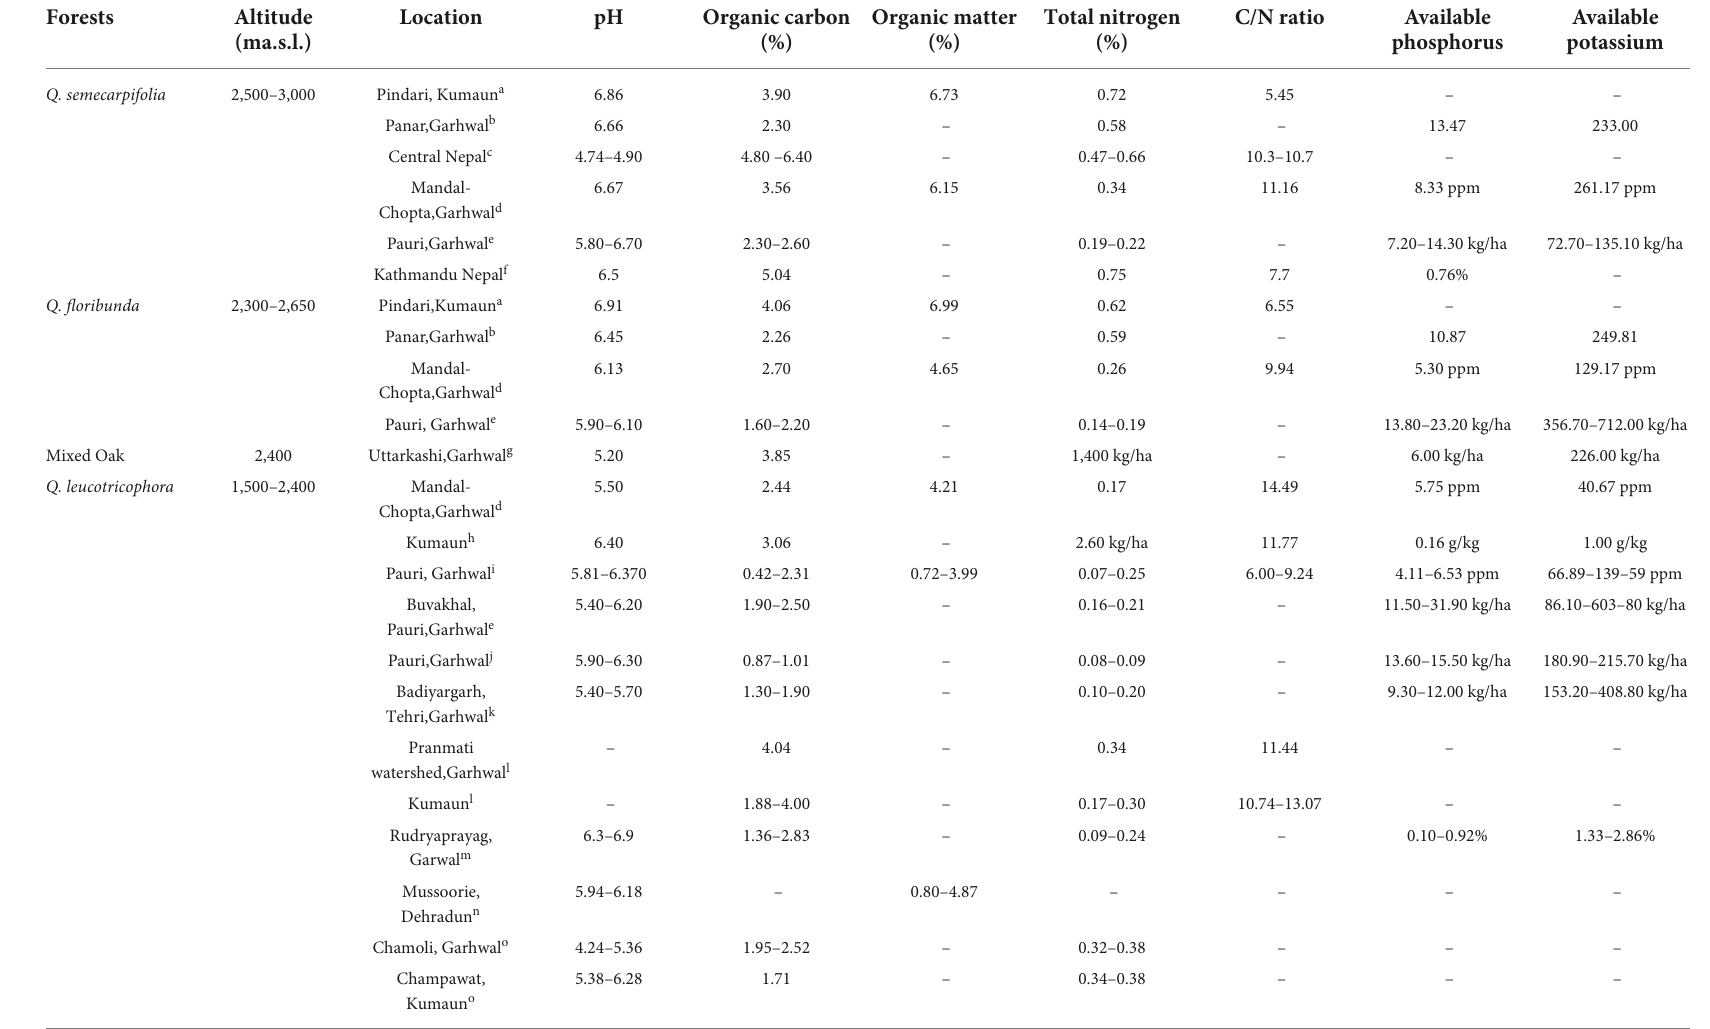
TABLE 2 Comparative account of chemical properties of soil in different types of Oak forests in the western Himalayas. Forests